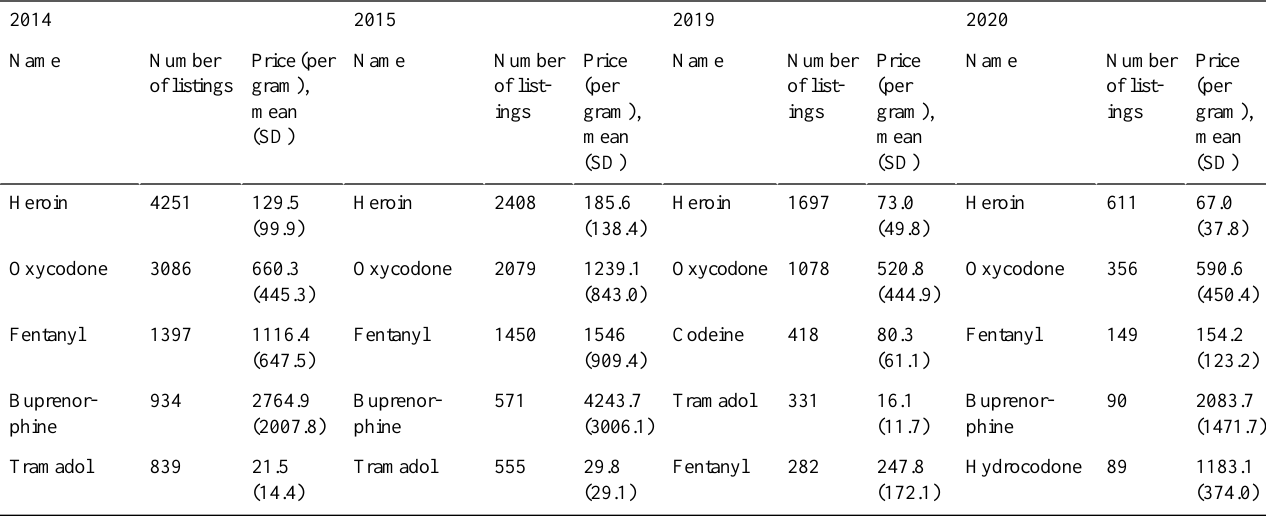
Table 6. Popular opioids according to different years. Note that data for 2020 only included data from January to March; price per gram is in US $.